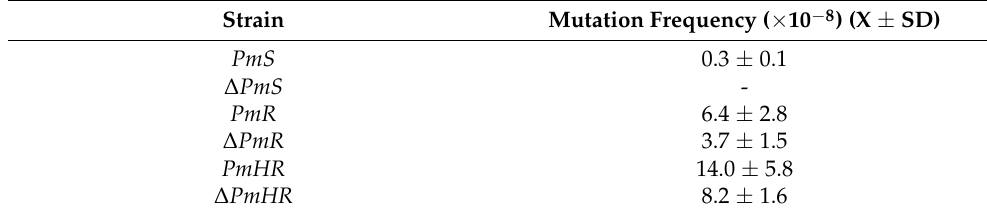
Table 3. Mutation frequency of Pm to ENR in six strains.